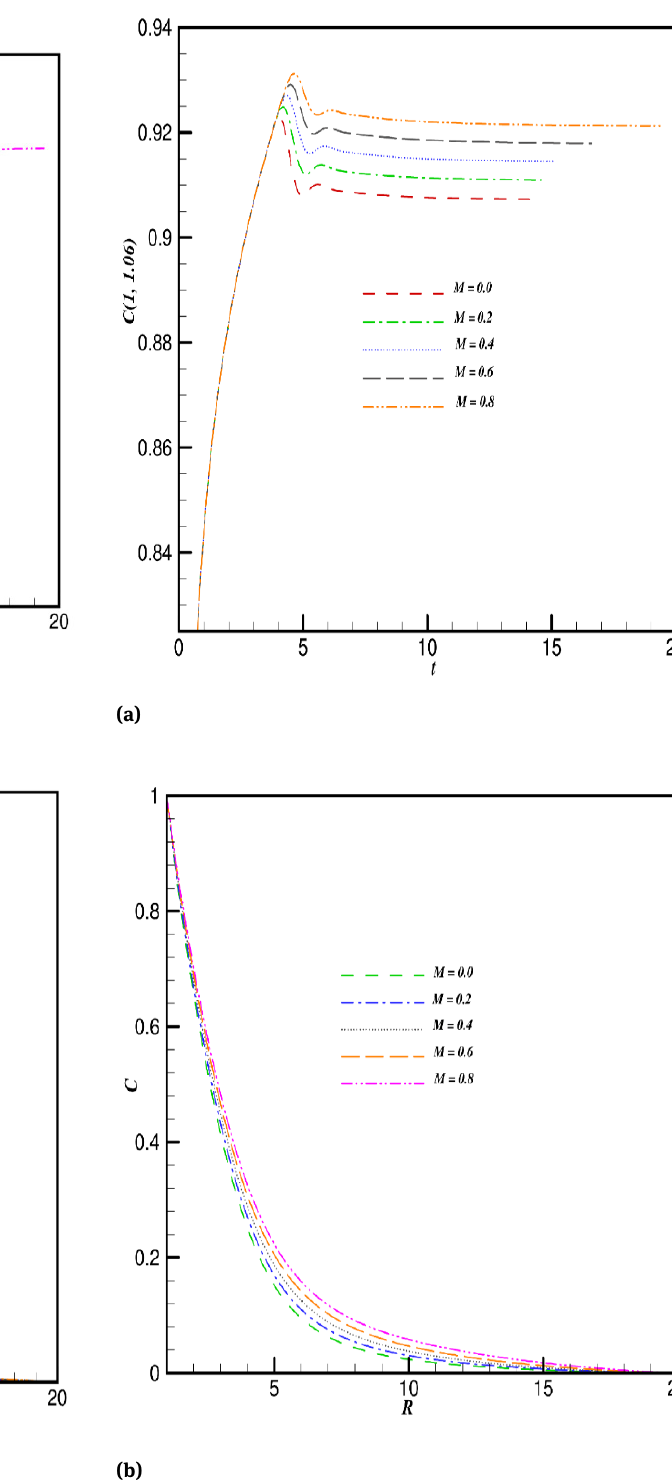
Figure 4: ( a ) Transient and ( b ) Steady state temperature profiles with fixed Sc = 0.6 , Pr = 0.7 , Bu = 1.0 , Kr = −0.2 , Nr = 2.0 , K 1 = 1.0 , Ec = 0.1 .